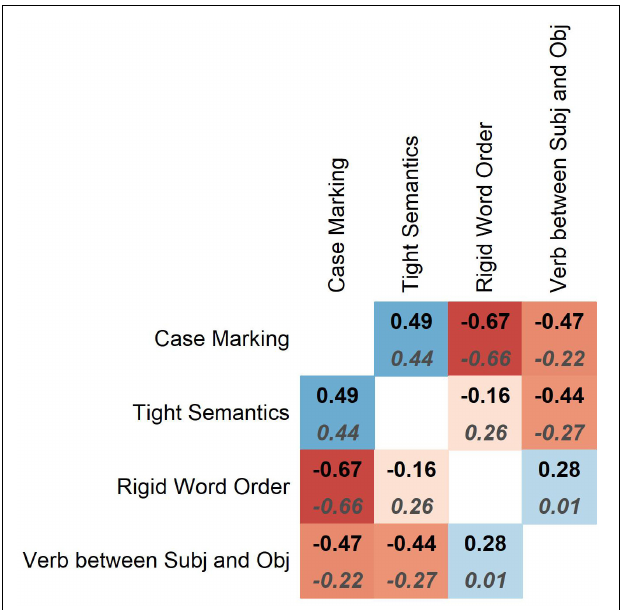
FIGURE 5 | Spearman’s correlation coefficients between pairs of variables, averaged across 1,000 simulations. Top: simple pairwise coefficients. Bottom: partial